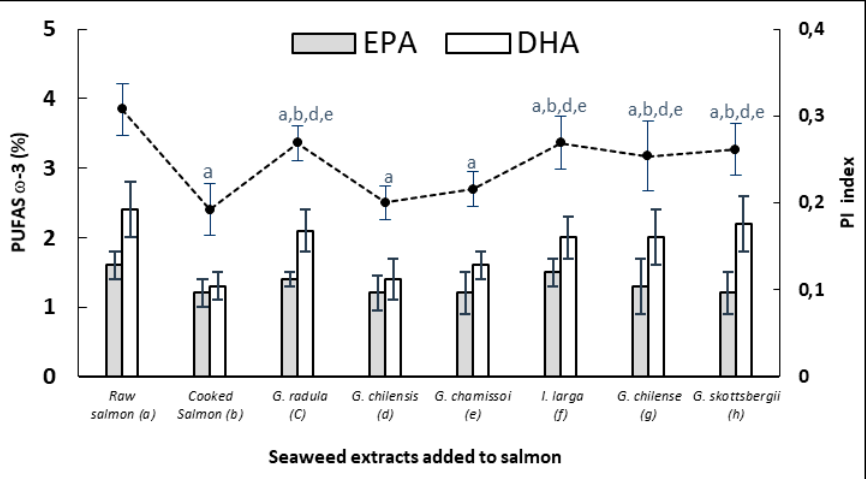
Figure 3. Polyene index of cooked and raw salmon pastes added with different extracts of red al- gae: a) Raw salmon paste, b) Cooked salmon paste, c) G. chamissoi , d) G. skottsbergii , e) G. radula , f) (a) Raw salmon paste, (b) Cooked salmon paste, (c) G. chamissoi , (d) G. skottsbergii , (e) G. radula , (f) I. larga , g) G. chilense , h) G. chilensis . Values are expressed as means ( n = 3) ± standard deviation. I. larga , (g) G. chilense , (h) G. chilensis . Values are expressed as means ( n = 3) ± standard deviation. Different letters correspond to mean values with significant difference ( p < 0.05). Different letters correspond to mean values with significant difference ( p <